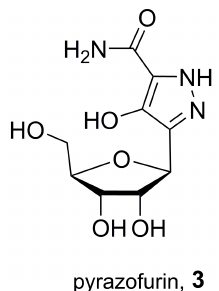
Figure 5. Pyrazofurin, or 3-β- D -ribofuranosyl-4-hydroxy-1 H -pyrazole-5-carboxamide ( 3 ), a natural pyrazole obtained from Streptomyces candidus strains.